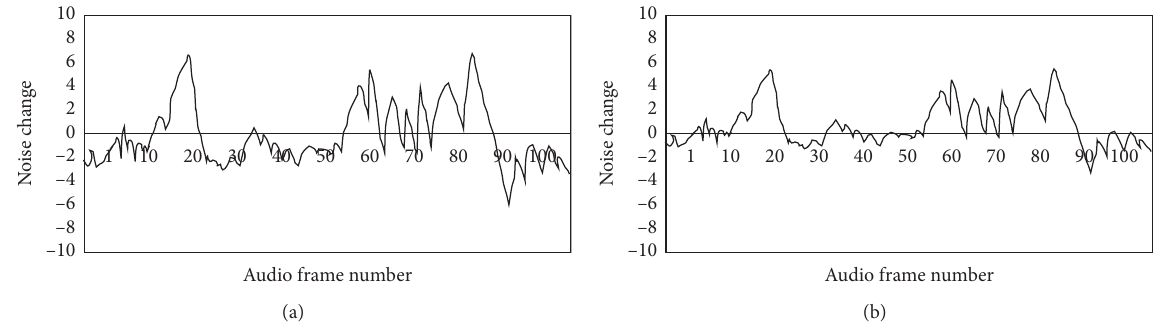
Figure 1: Music signal noise removal effect test: (a) noisy music signal; (b) noisy-removed music